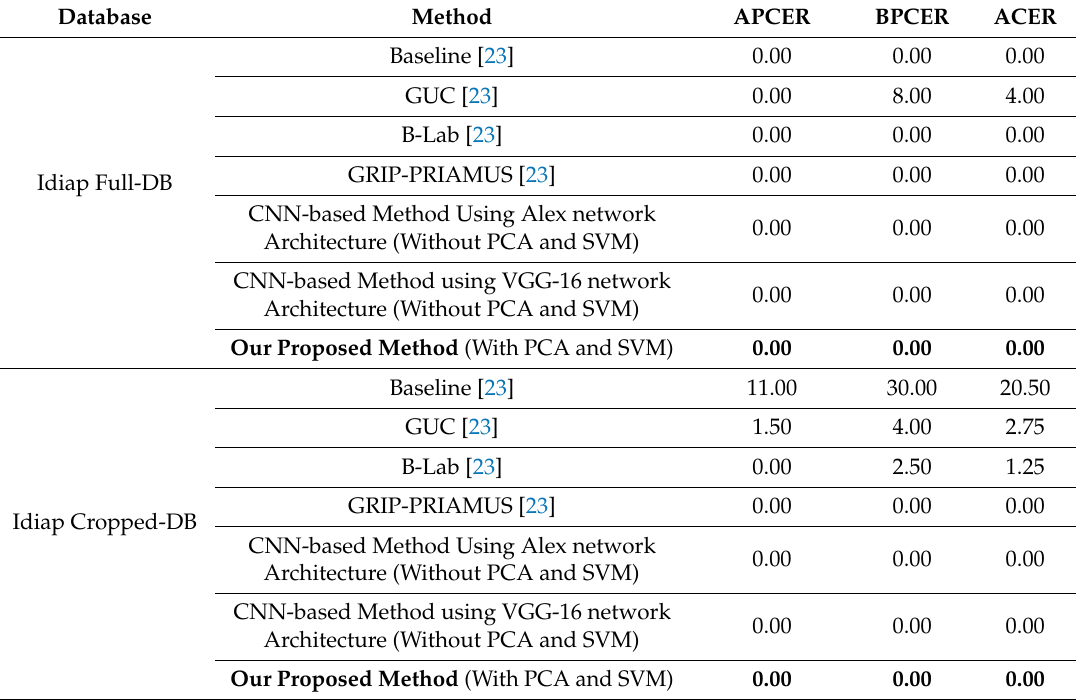
Table 22. Comparison of PAD errors using our proposed method and various methods using Idiap Full-DB and Idiap Cropped-DB databases (unit: